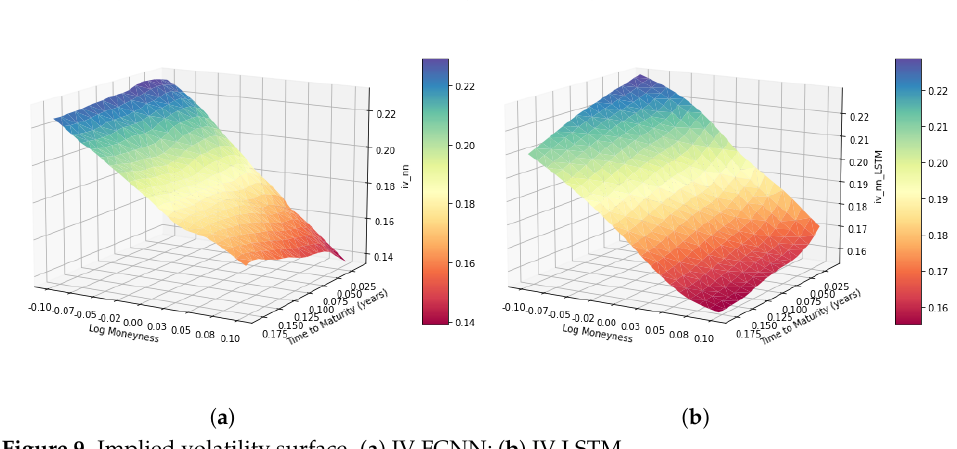
Figure 9. Implied volatility surface. ( a ) IV FCNN; ( b ) IV LSTM.